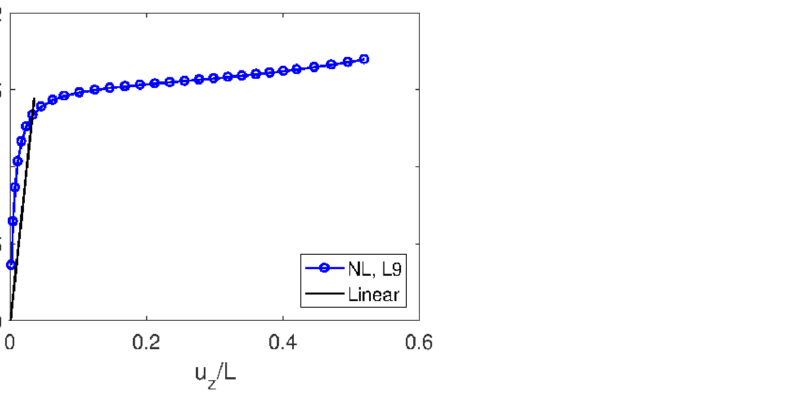
and σ ∗ yz = σ yz / σ yz max max